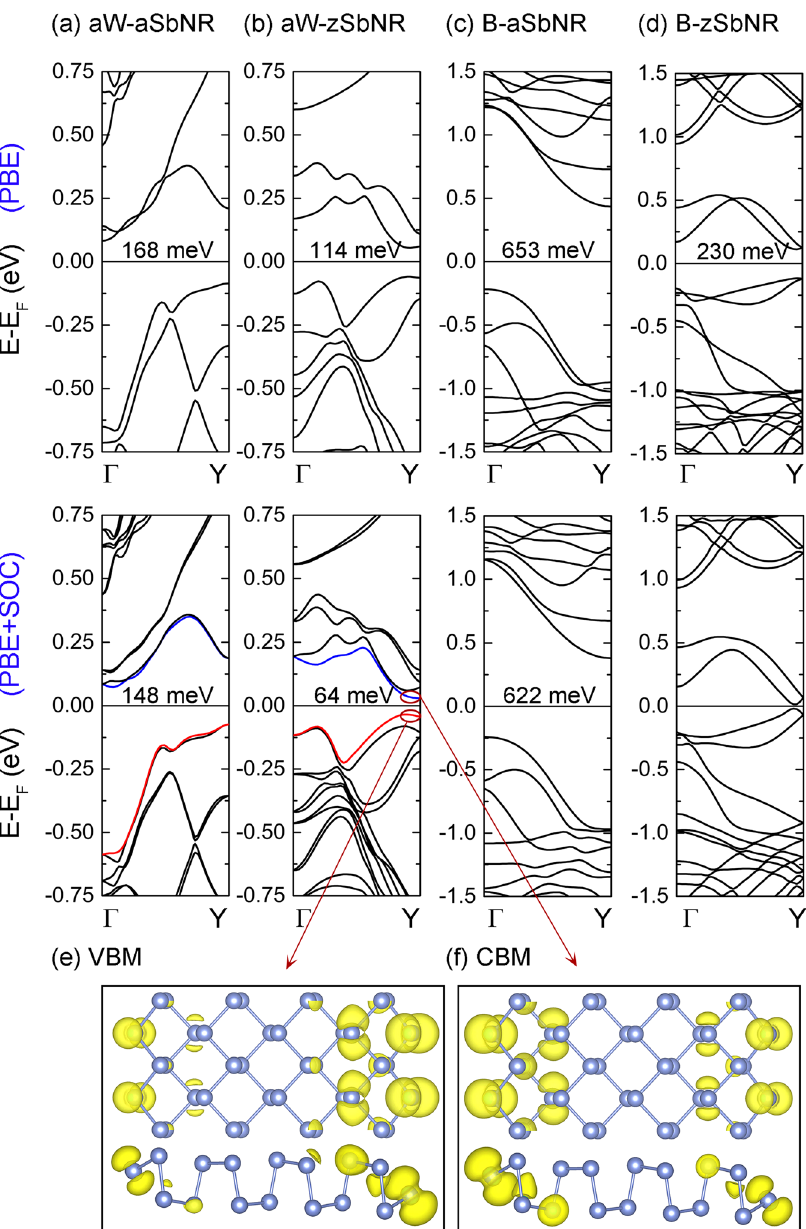
Fig. 3 Band structure of a aW-aSbNR, b aW-zSbNR, c B-aSbNR, and d B-zSbNR with and without SOC. The UVB and LCB of aW-aSbNR and aW- zSbNR are highlighted by red and blue lines. Partial charge densities of e VBM and f CBM of aW-zSbNR. The isosurface value is 0.25 e/nm